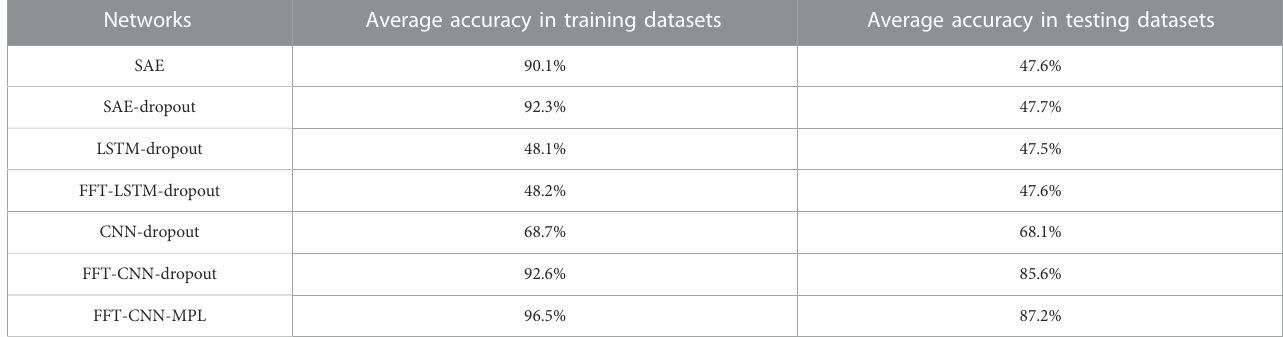
TABLE 7 Comparison among different